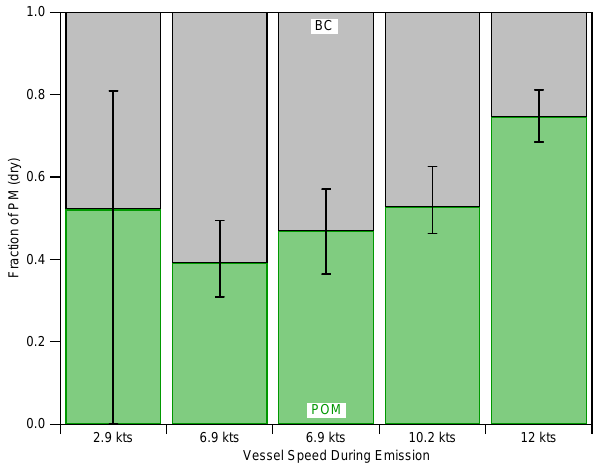
Fig. 2. The fraction of PM 1 that is BC (gray) or POM (green) as a function of vessel speed, determined from the weighted average POM and BC